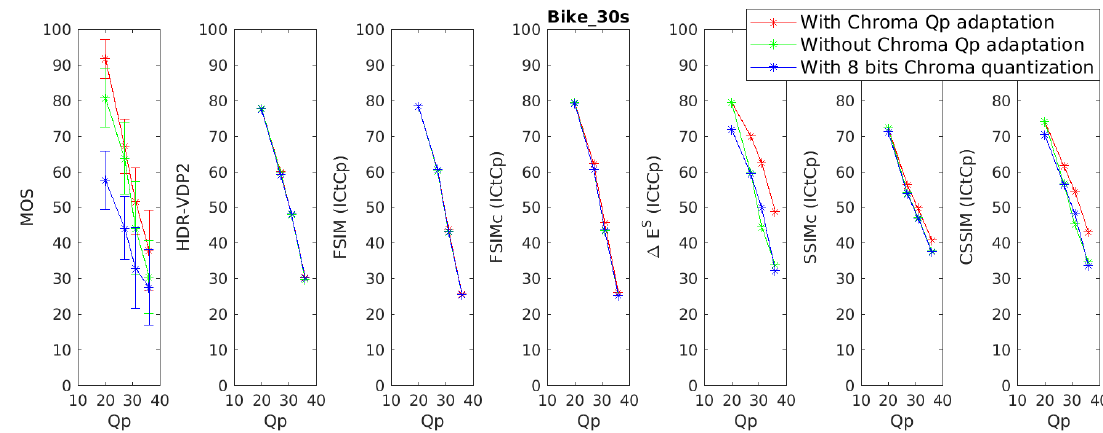
Figure A7. Subjective and objective scores for the image Bike_30s.